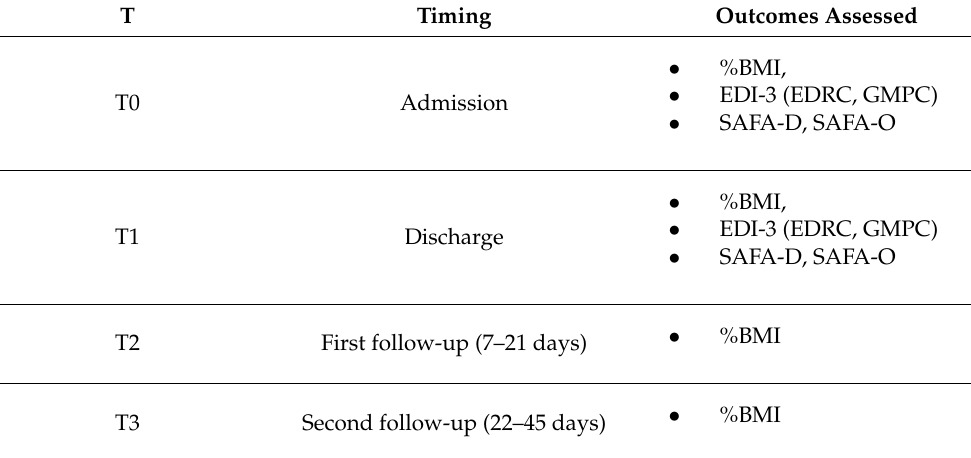
Table 1. Timeline of the